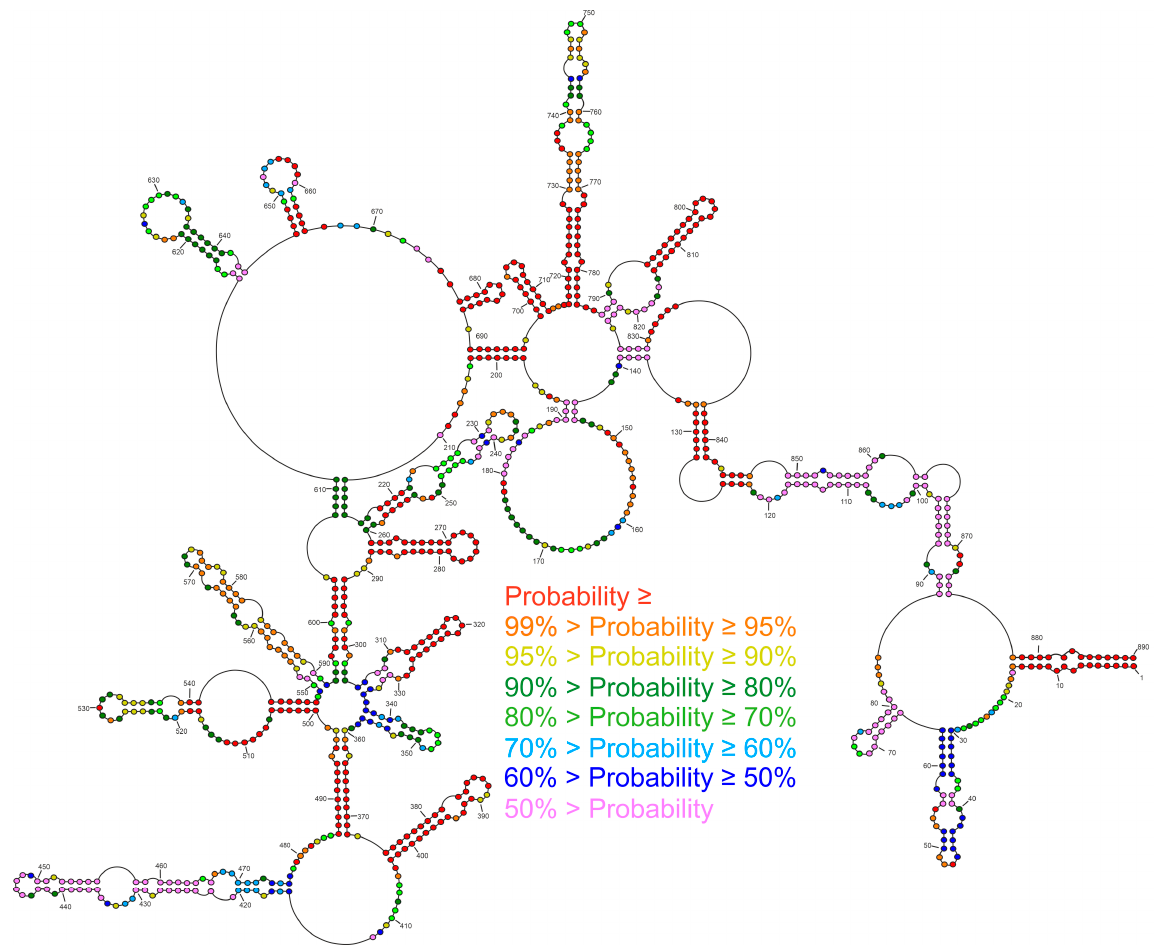
Figure 5. Base-pairing probabilities of single- and double-stranded regions of the vRNA8 A/California/04/2009 structure in cell lysates. The colors indicate the percentage of pairing probability. The probabilities were calculated via the partition function in RNAstructure 6.2 using experimental data constraints. Table 1. The motifs with the highest, ≥ 95%, conservation of the base-pairing within IAV, predicted in local and global MFE structures. The motifs predicted in both local and global structures are